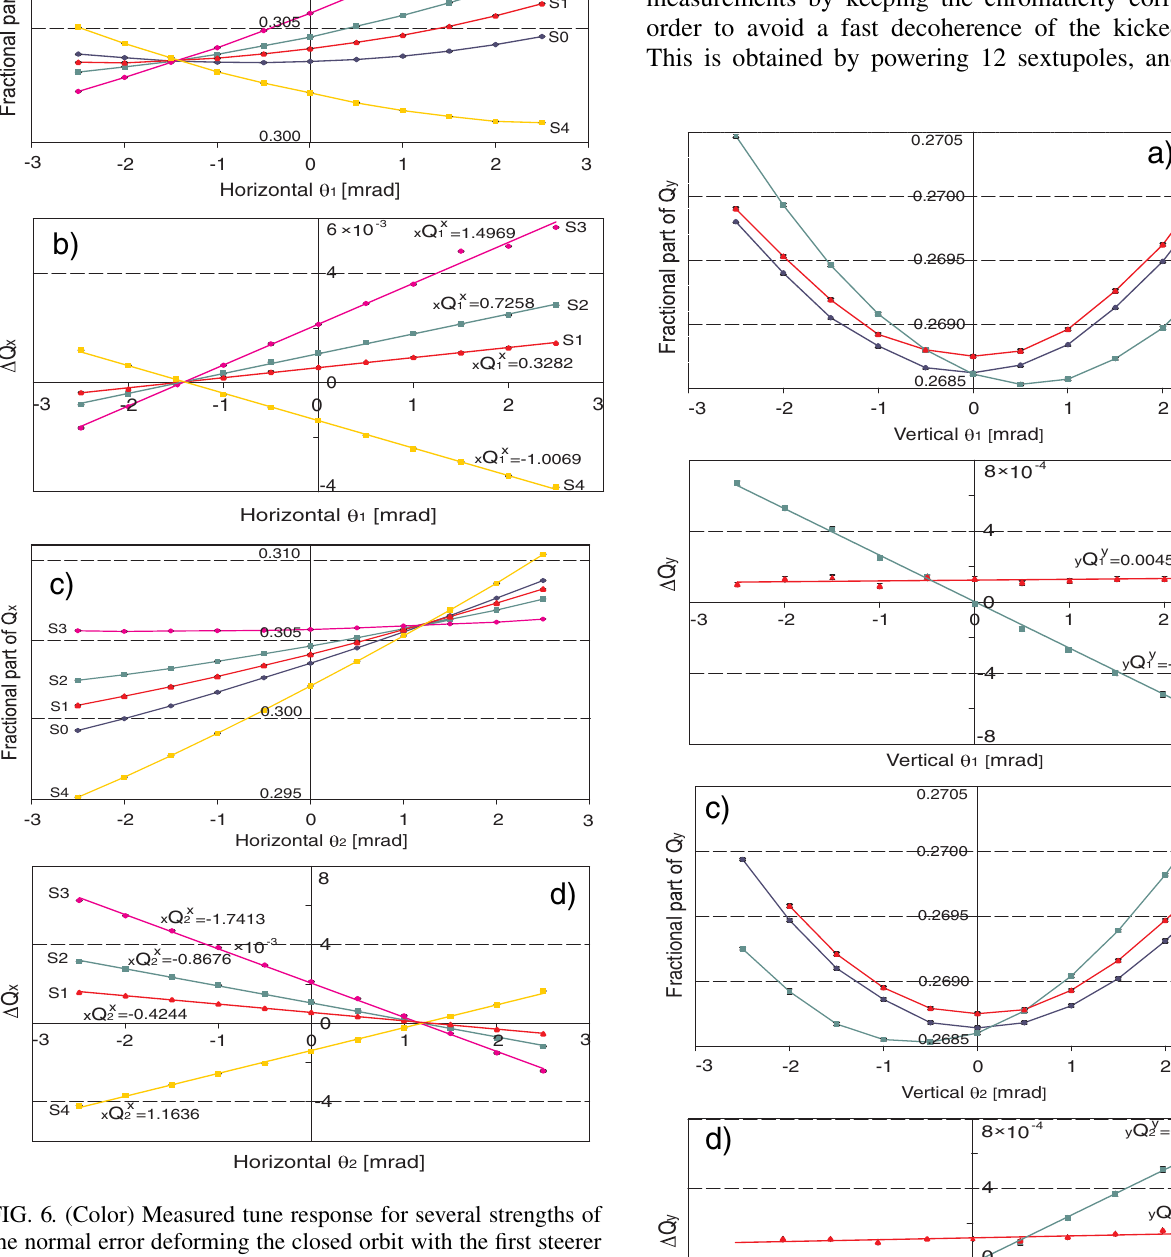
Figs. 7(a) and 7(c) we show the tune response curves for these two probing errors. The parabolic behavior can be explained by Eqs. (18) and (20). In fact, we performed the measurements by keeping the chromaticity corrected in order to avoid a fast decoherence of the kicked beam.